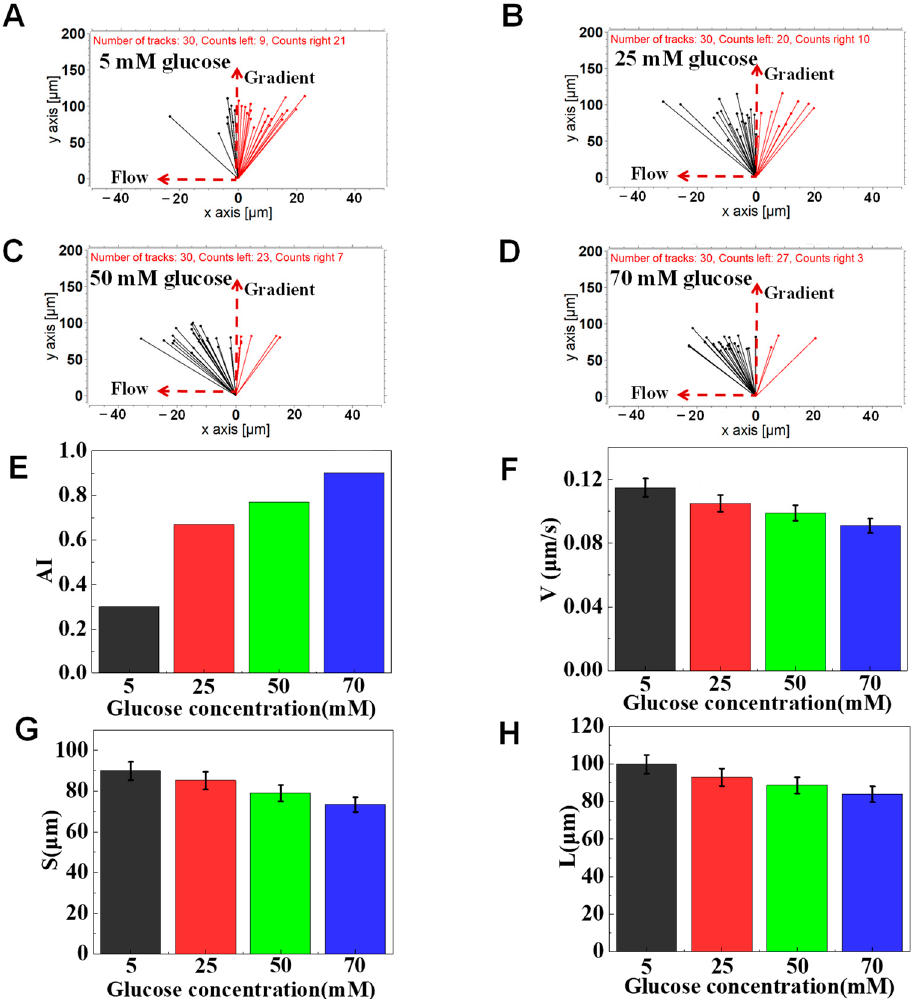
Figure 6. Chemotaxis of glucose-treated cells in 100 nM of fMLP gradient. ( A ) The connecting line between the initial position and the end position of cells pretreated with 5 mM glucose. ( B ) The connecting line between the initial position and the end position of cells pretreated with 25 mM glucose. ( C ) The connecting line between the initial position and the end position of cells pretreated with 50 mM glucose. ( D ) The connecting line between the initial position and the end position of cells pretreated with 70 mM glucose. ( E – H ) Comparison of quantitative cell migration parameters including drifting index (AI), cell velocity (V), the displacement along the gradient (S), and the whole movement distance (L).